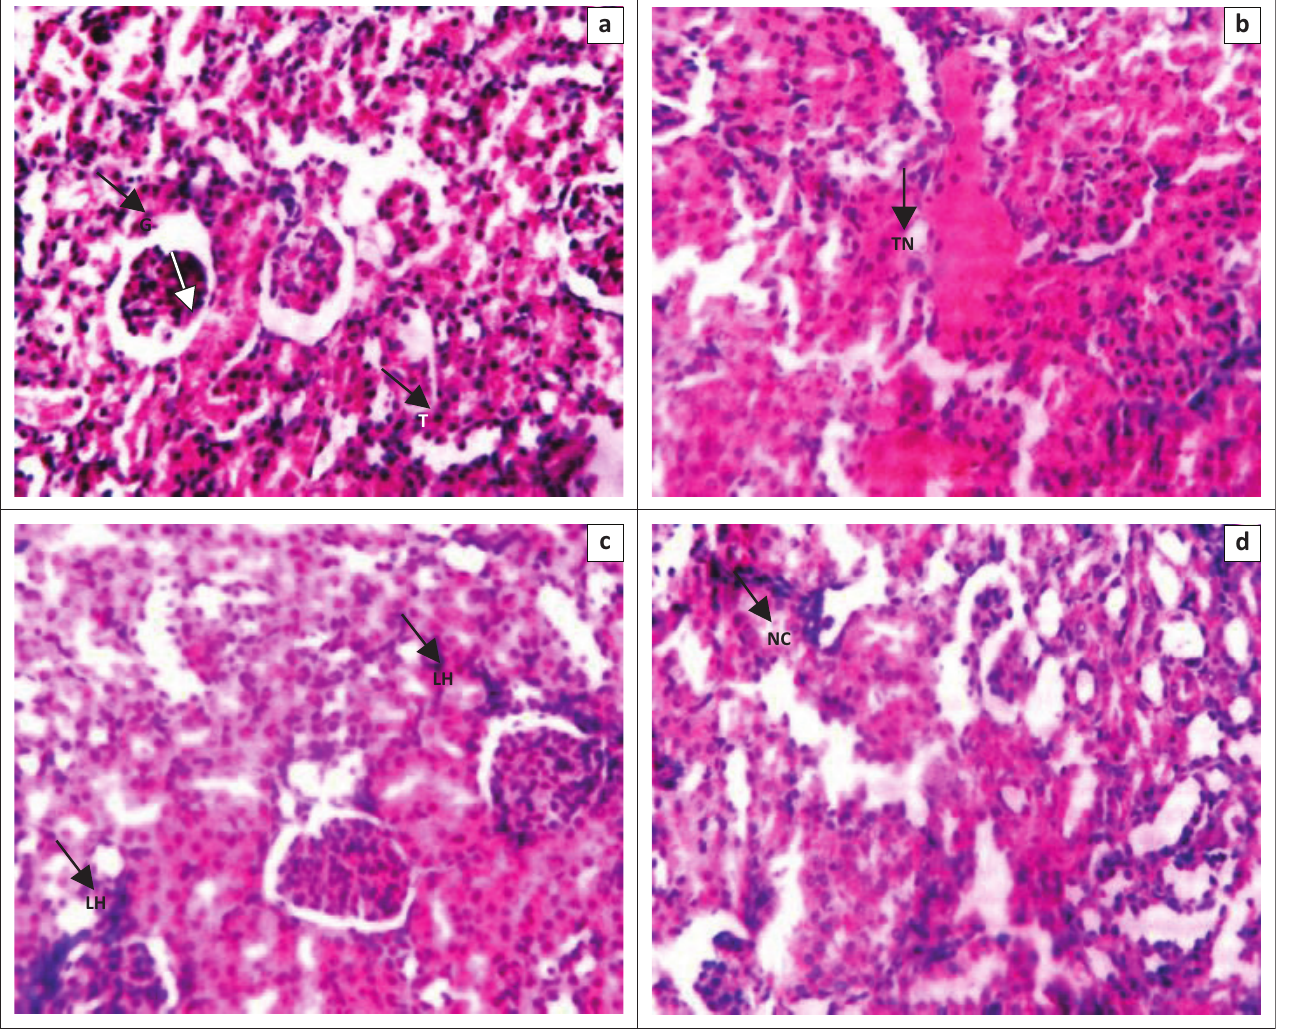
FIGURE 1: Photomicrograph showing the kidney section of (a) control group (1 mL/kg distilled water) shows the normal architecture tubules (T) and glomerulus; (b) treated with 500 mg/kg of n -hexane extract shows moderate and slight tubular necrosis; (c) treated with 1000 mg/kg of n -hexane extract shows moderate lymphocyte hyperplasia; (d) treated with 1500 mg/kg of n -hexane extract shows tubular necrosis moderate and slight lymphocyte hyperplasia necrosis (haematoxylin and eosin stain; original magnification ×